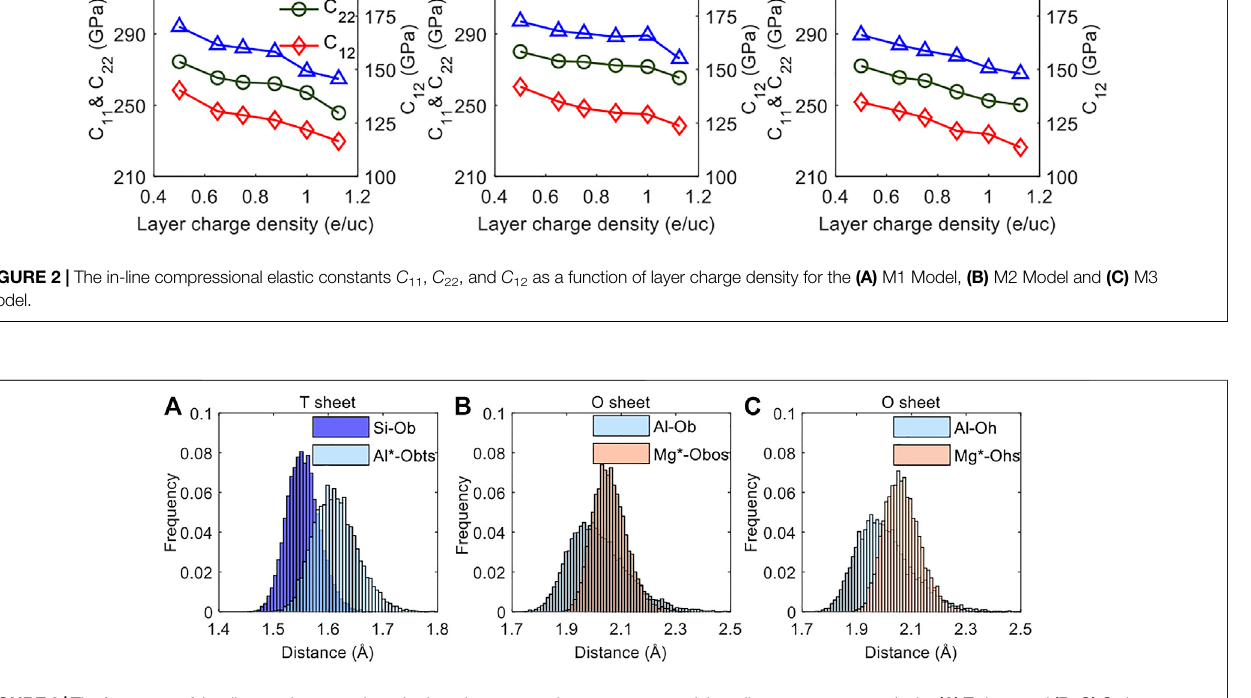
FIGURE3 | The frequency ofthe distancebetween the substituted atomor replacement atomand theadjacentoxygen atom in the (A) Tsheetand (B, C) O sheet oftheMMTlayerbeforeandaftertheisomorphoussubstitution.Thesymbol*representstheatomsaftersubstitution.IntheOsheet,theAl/Mg-Odistancesareclassi fi ed into the Al/Mg-Ob(os) and Al/Mg-Oh(s)distancesaccording tothe type ofthe connected oxygen atoms (i.e., bridging oxygenor hydroxyloxygen)asshown in Figure 1 .